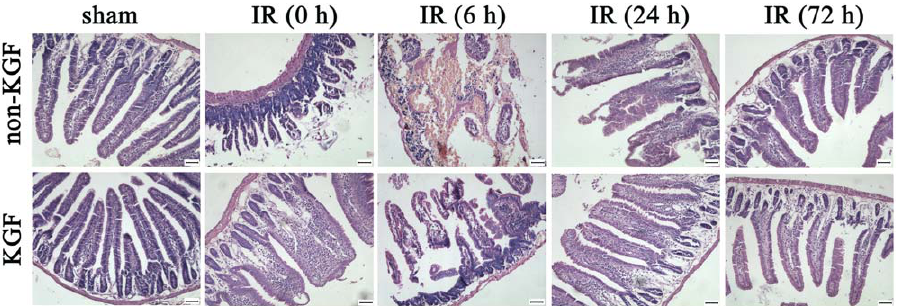
Figure 2. Histological changes in intestinal I/R mice with KGF treatment by H&E staining. More severe mucosal injury was observed in I/R group than in I/R + KGF group, while no mucosal injury was noted in the sham group; Original magnification: 6 200, n=6 per group. Scale bar=50 m